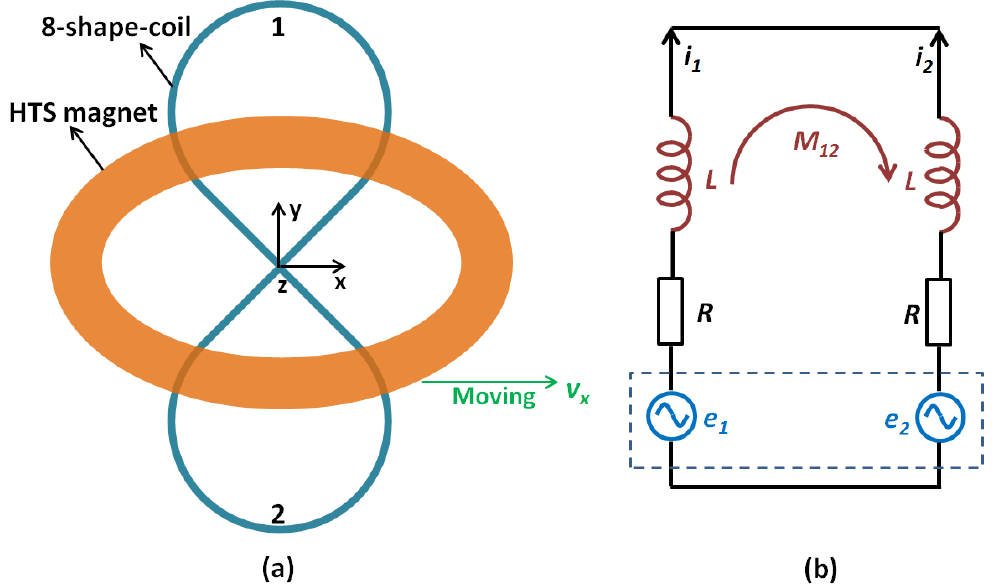
Figure 2. Working principle of the superconducting electrodynamic suspension of the HTS maglev: ( a ) HTS magnet and 8-shape coil, ( b ) equivalent circuit.